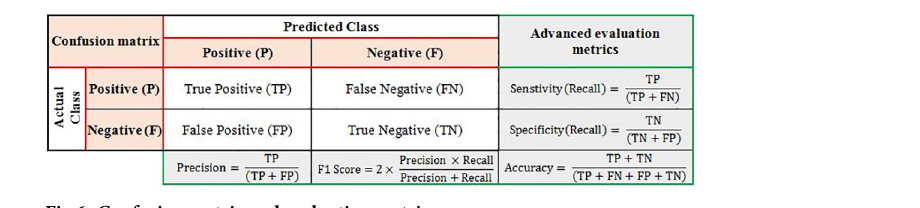
Fig 6. Confusion matrix and evaluation metrics.